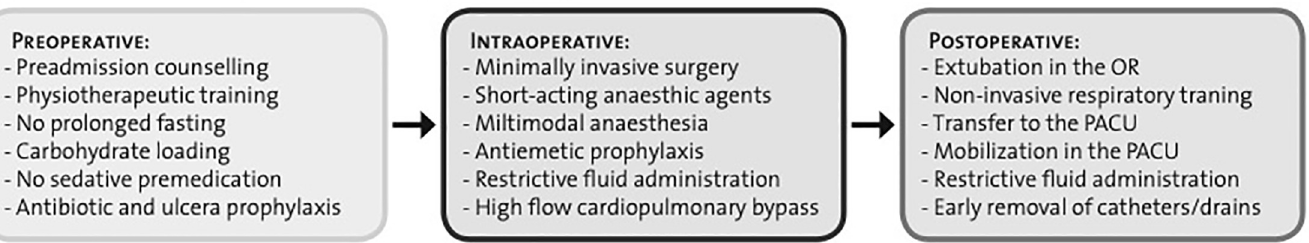
Fig 1. Key features of the ERAS program (in accordance with the recommendations of the Enhanced Recovery after Surgery Society 1 ).